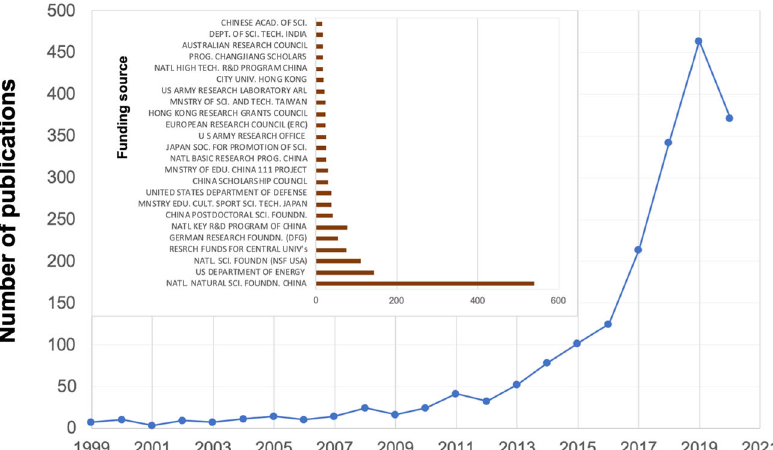
Fig. 2 Number of unique archival publications in the fi eld of HEAs, CCAs and MPEAs as determined from Web of Science TM for the period of 1999 to August 2020. The inset indicates the associated funding source attributed to the respective